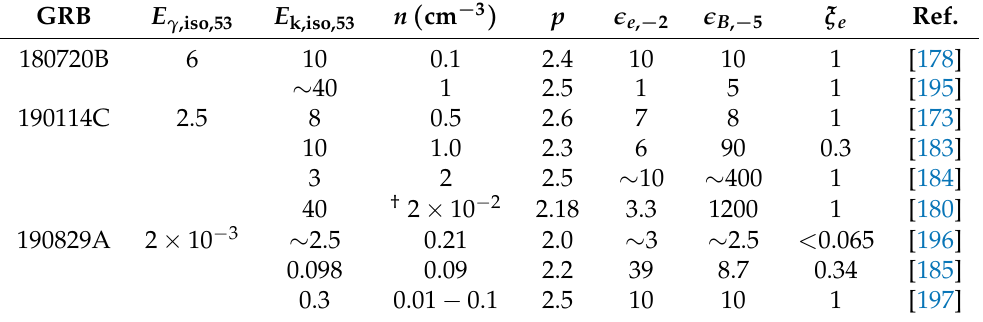
Table 1. Afterglow fit parameters for GRBs with VHE emission. † Shows A (cid:63) parameter for a wind